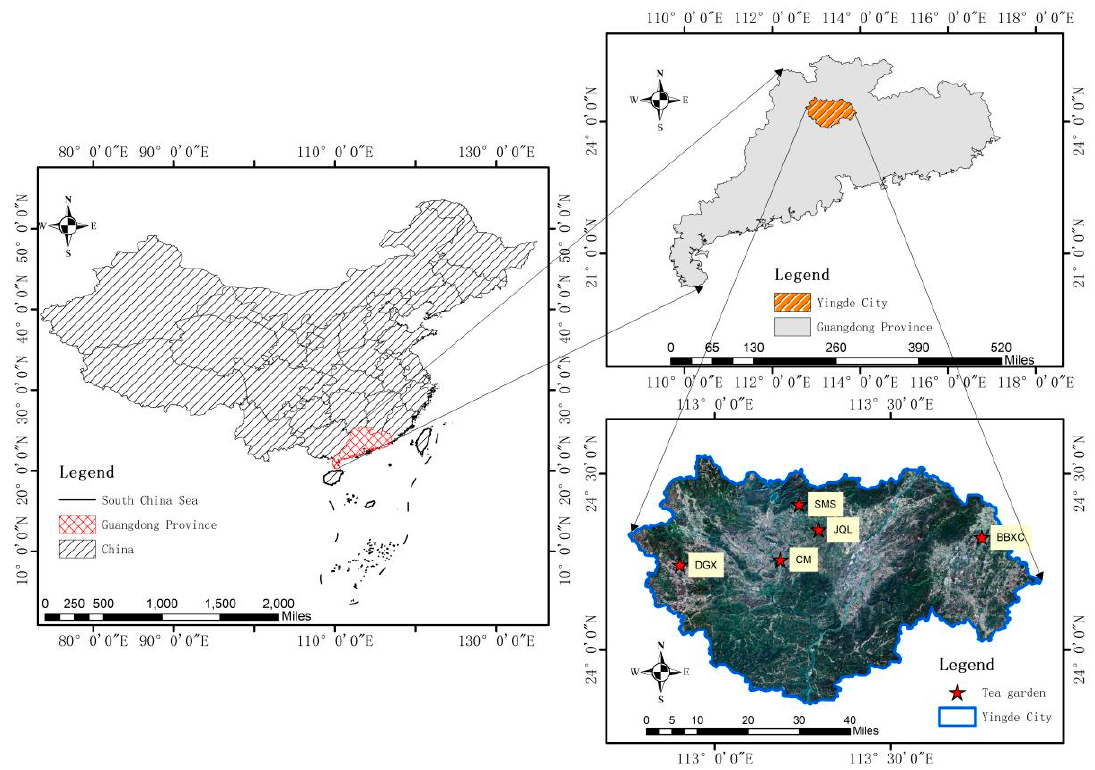
Figure 1. Geographical location of the study area.